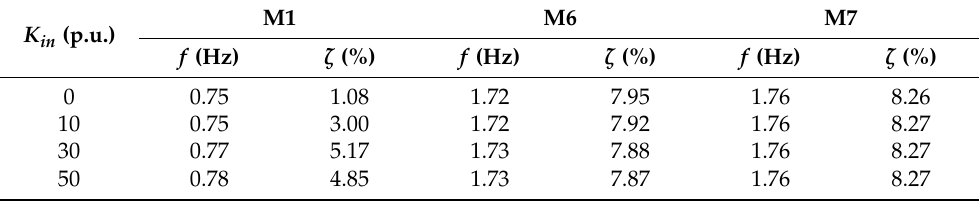
Table 16. Effect of increasing SI contribution from FCWTs on the modes in the Lines out of Service DP. K in (p.u.)